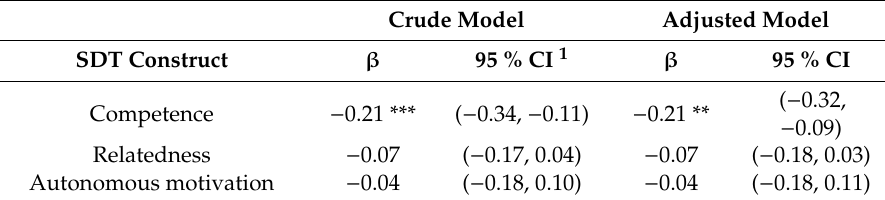
Table 5. Linear regression models on the association of unhealthy dietary pattern and SDT variables.